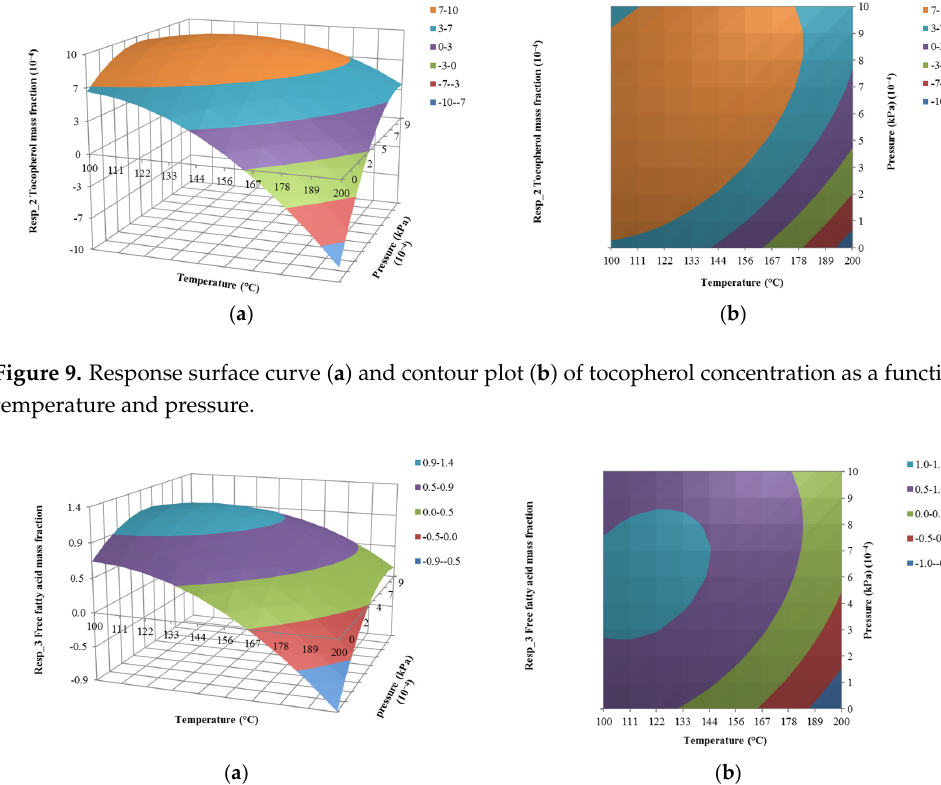
Figure 8. Response surface curve ( a ) and contour plots ( b ) of beta-carotene concentration as a function of temperature and pressure.